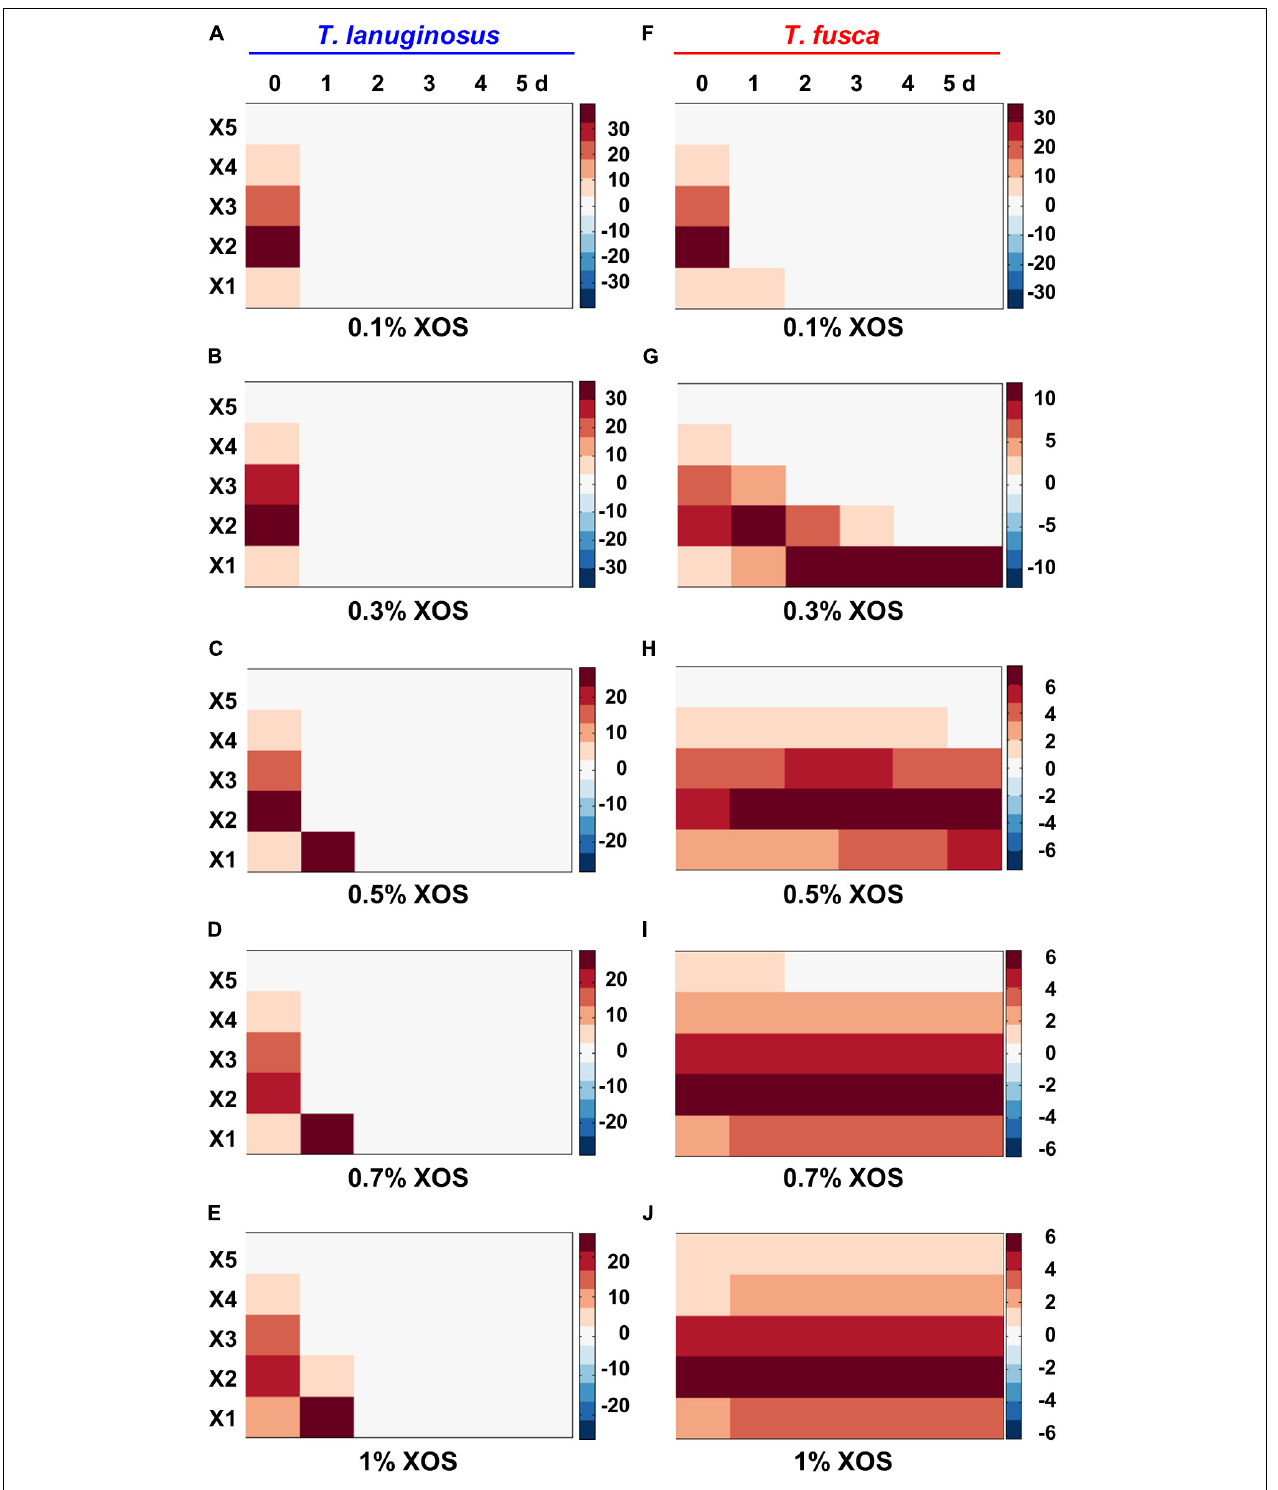
FIGURE 4 | The comparison and quantitative determination of extracellular reducing sugars when T. lanuginosus or T. fusca was grown alone on different concentration of XOS. (A–E) Represent the extracellular reducing sugars of T. lanuginosus grown on concentrations of XOS ranging from 0.1 to 1% (w/v). (F–J) Represent the extracellular reducing sugars of T. fusca grown on concentrations of XOS ranging from 0.1 to 1% (w/v). T. lanuginosus represents the monoculture of T. lanuginosus . T. fusca represents the monoculture of T. fusca . Lane M represents standard marker. X1–X5 represent xylose, xylobiose, xylotriose, xylotetraose and xylopentaose, respectively. XOS,